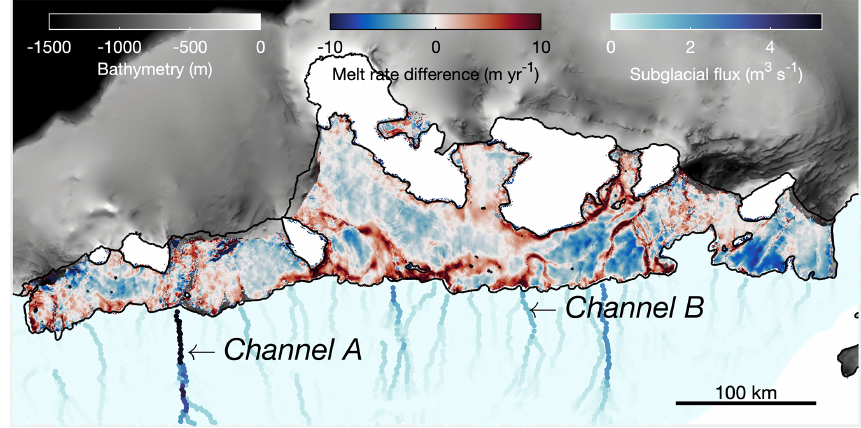
Figure 3. The melt rate difference between observed melt rate and melt rate with no discharge. Red indicates regions where observed melt rates are higher than can be explained by temperature- and depth-dependent forcing alone. The blue fluxes indicate subglacial meltwater. The gray background is the bathymetry from IBCSO (Arndt et al.,